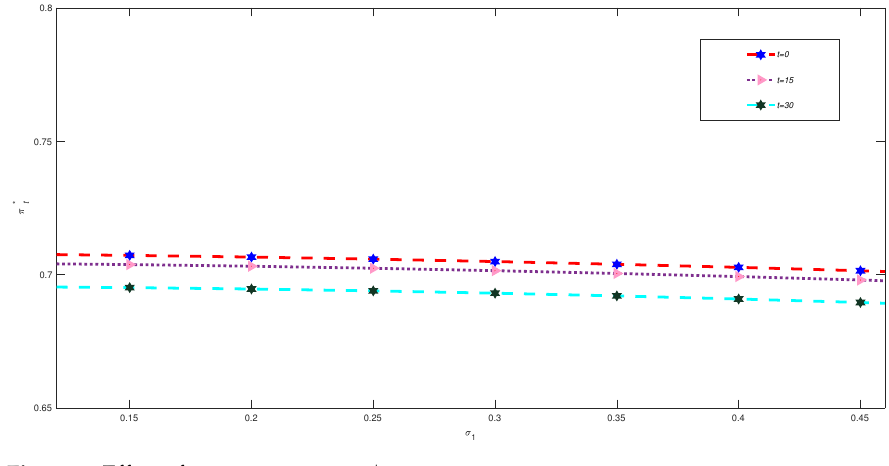
Figure 2. Effect of parameter σ 1 on π ∗